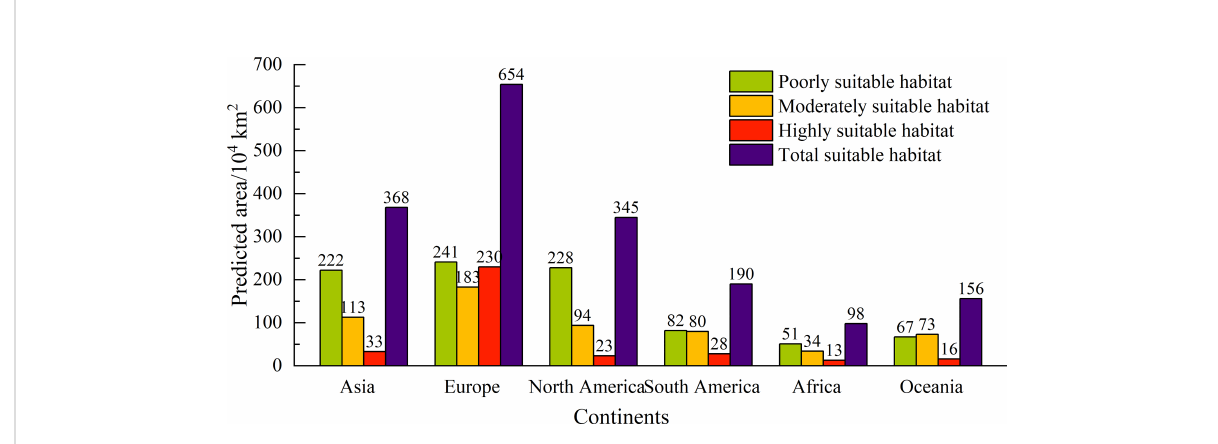
FIGURE 3 Different types of suitable areas for Lolium temulentum across six continents under the current climate.